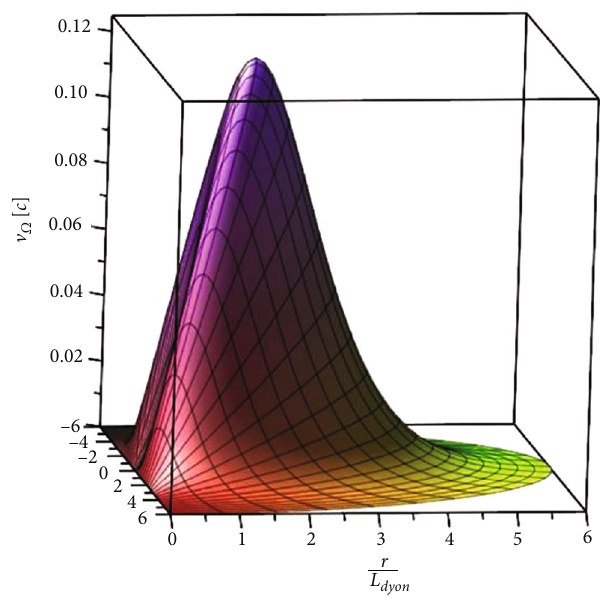
Figure 3: Frame dragging. Shown in the plot is the speed, with which reference frames are dragged around the wormhole relative to a stationary reference frame in a region of space far from the wormhole, i.e., r ⟶ ∞ . The speed, v Ω , is given as a multiple of the speed of